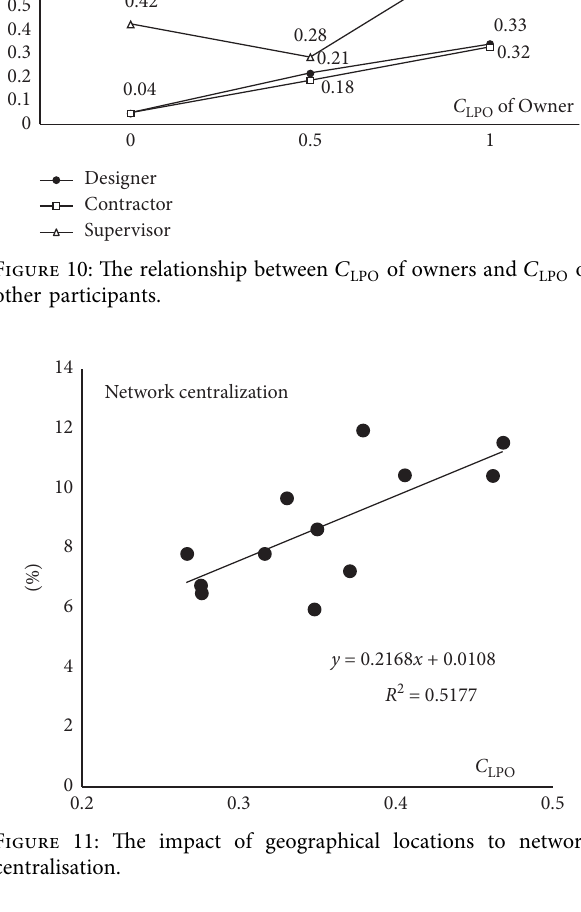
Figure 11: The impact of geographical locations to network centralisation.